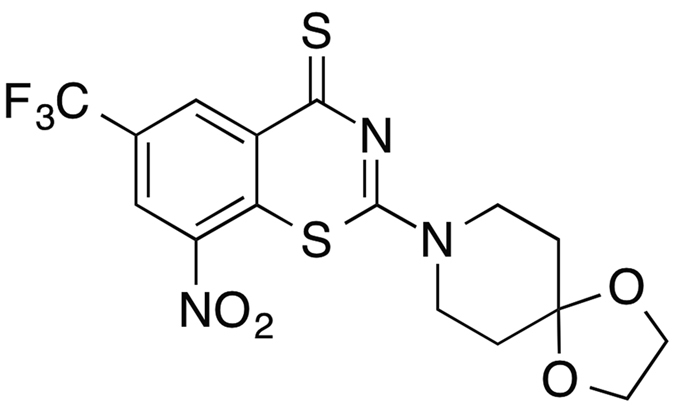
The structure of compound SKLB-TB1001.